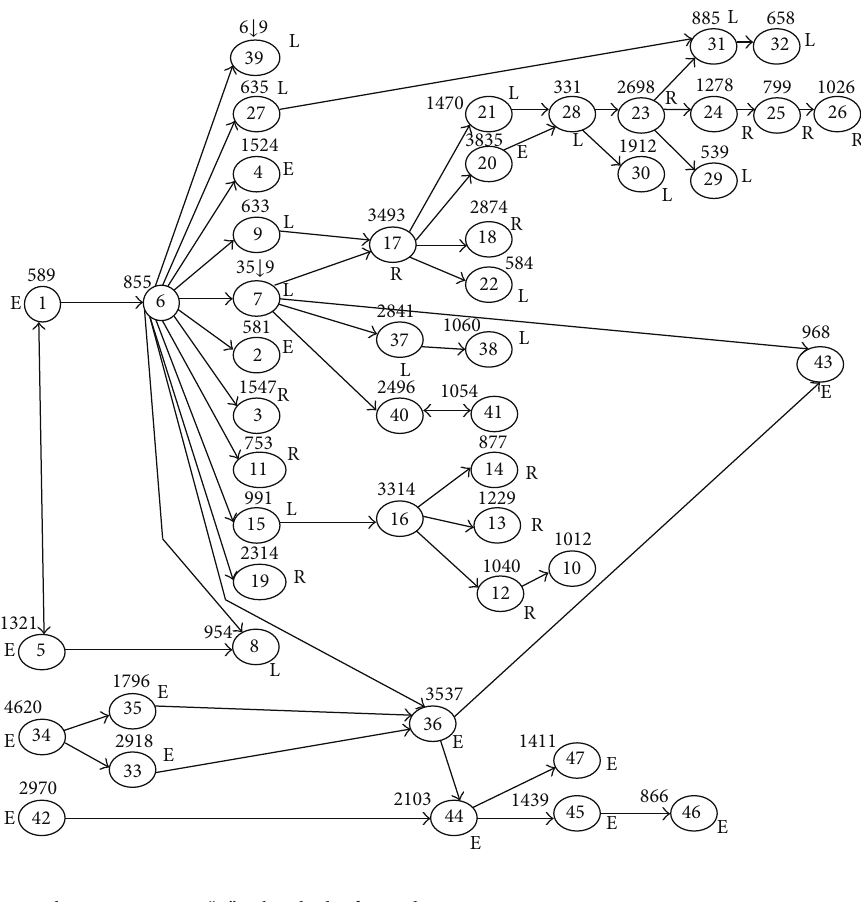
Figure 7: Precedence diagram along with task time and operation directions of 47 tasks TSALBP (Source: [14]).